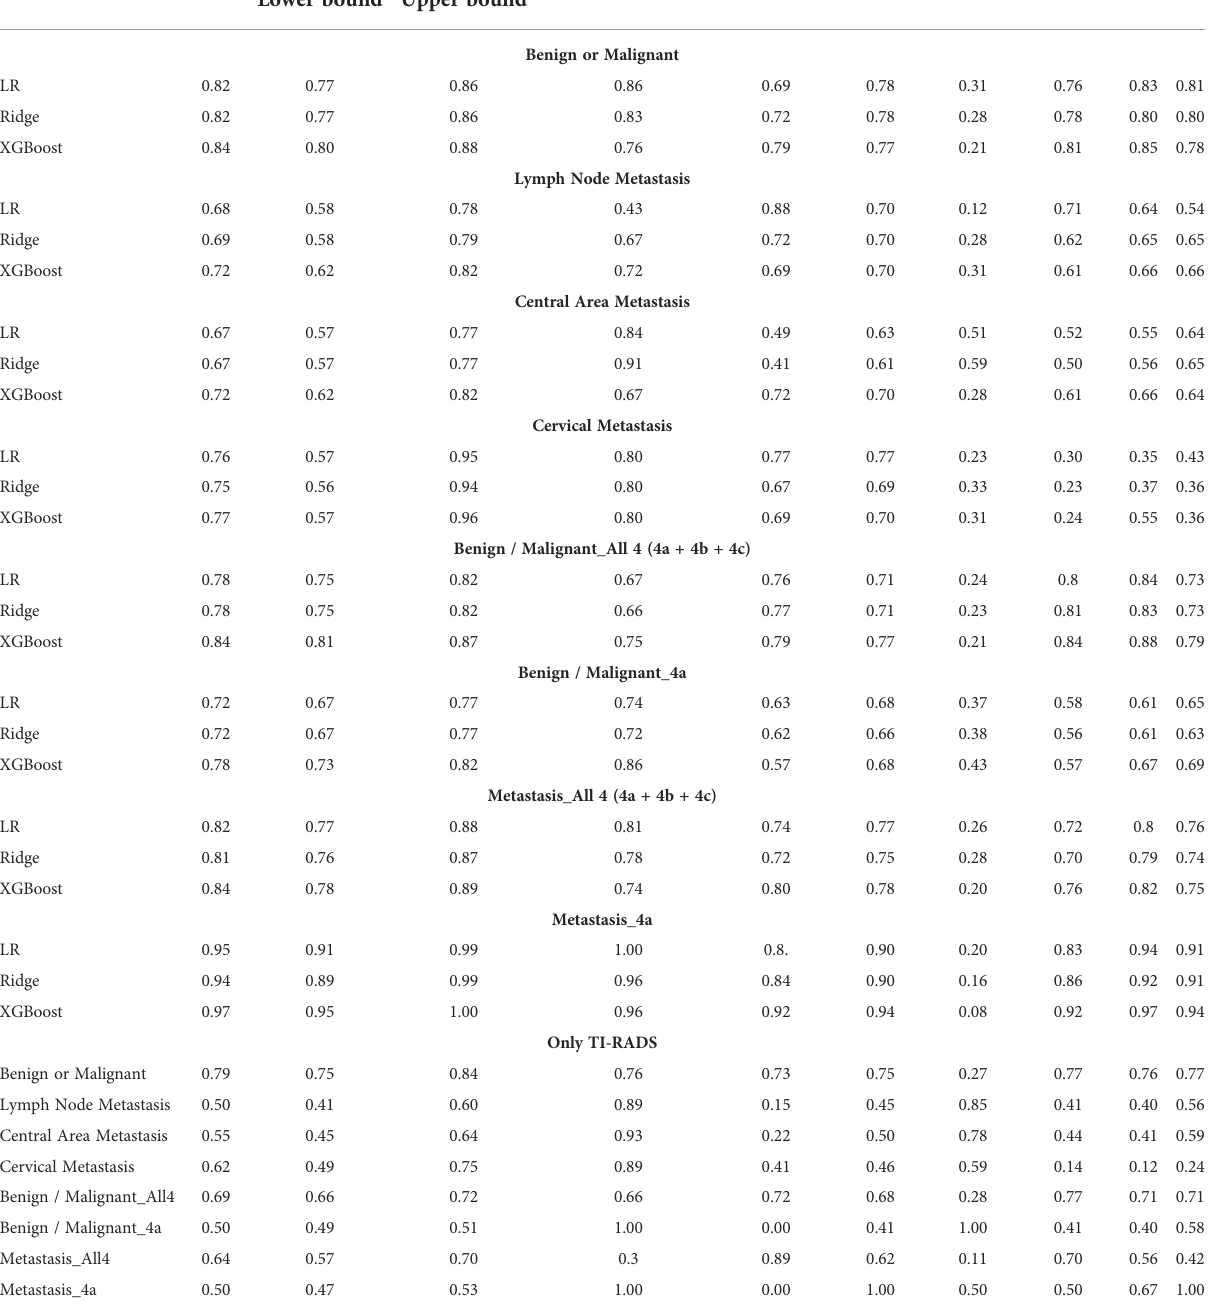
TABLE 2 Performance summary.